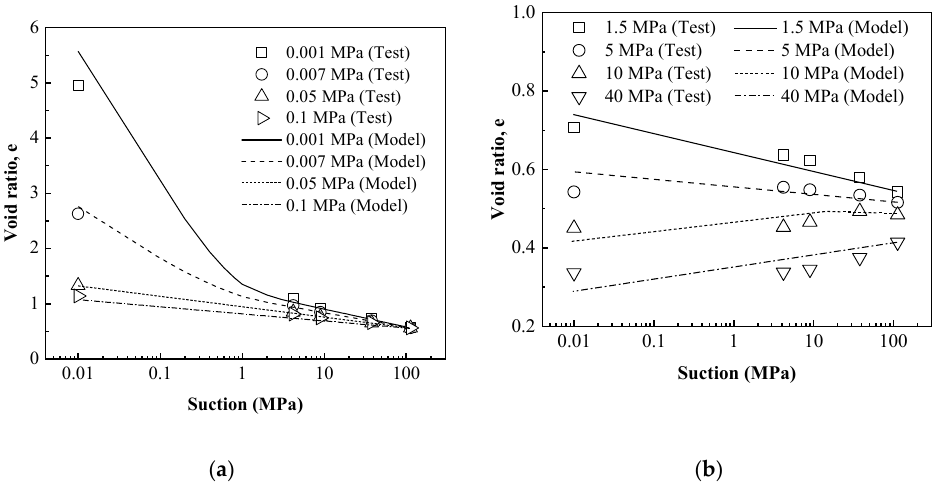
Table 2. Parameters for GMZ bentonite.